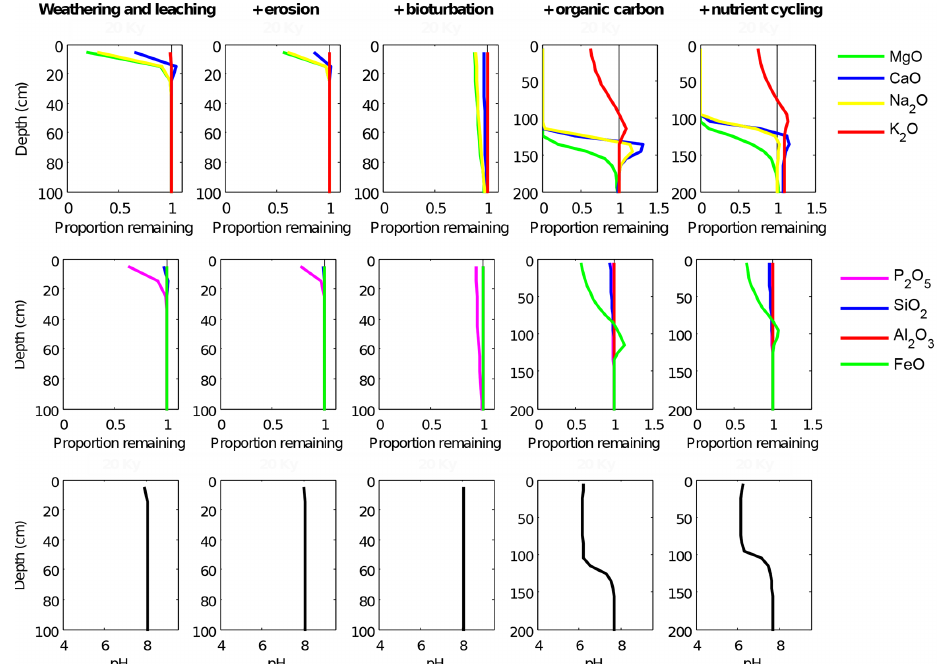
Figure 2. Vertical distributions of pH and the relative depletion/enrichment of the elemental model oxides after 20kyr of soil development for five different model runs of increasing complexity. Values < 1 indicate a loss relative to the parent material, and values > 1 indicate relative